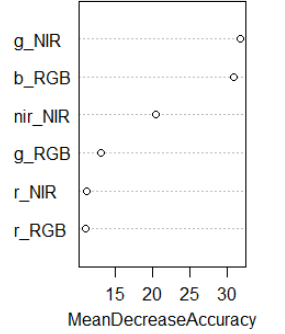
Figure 11. Variable importance for